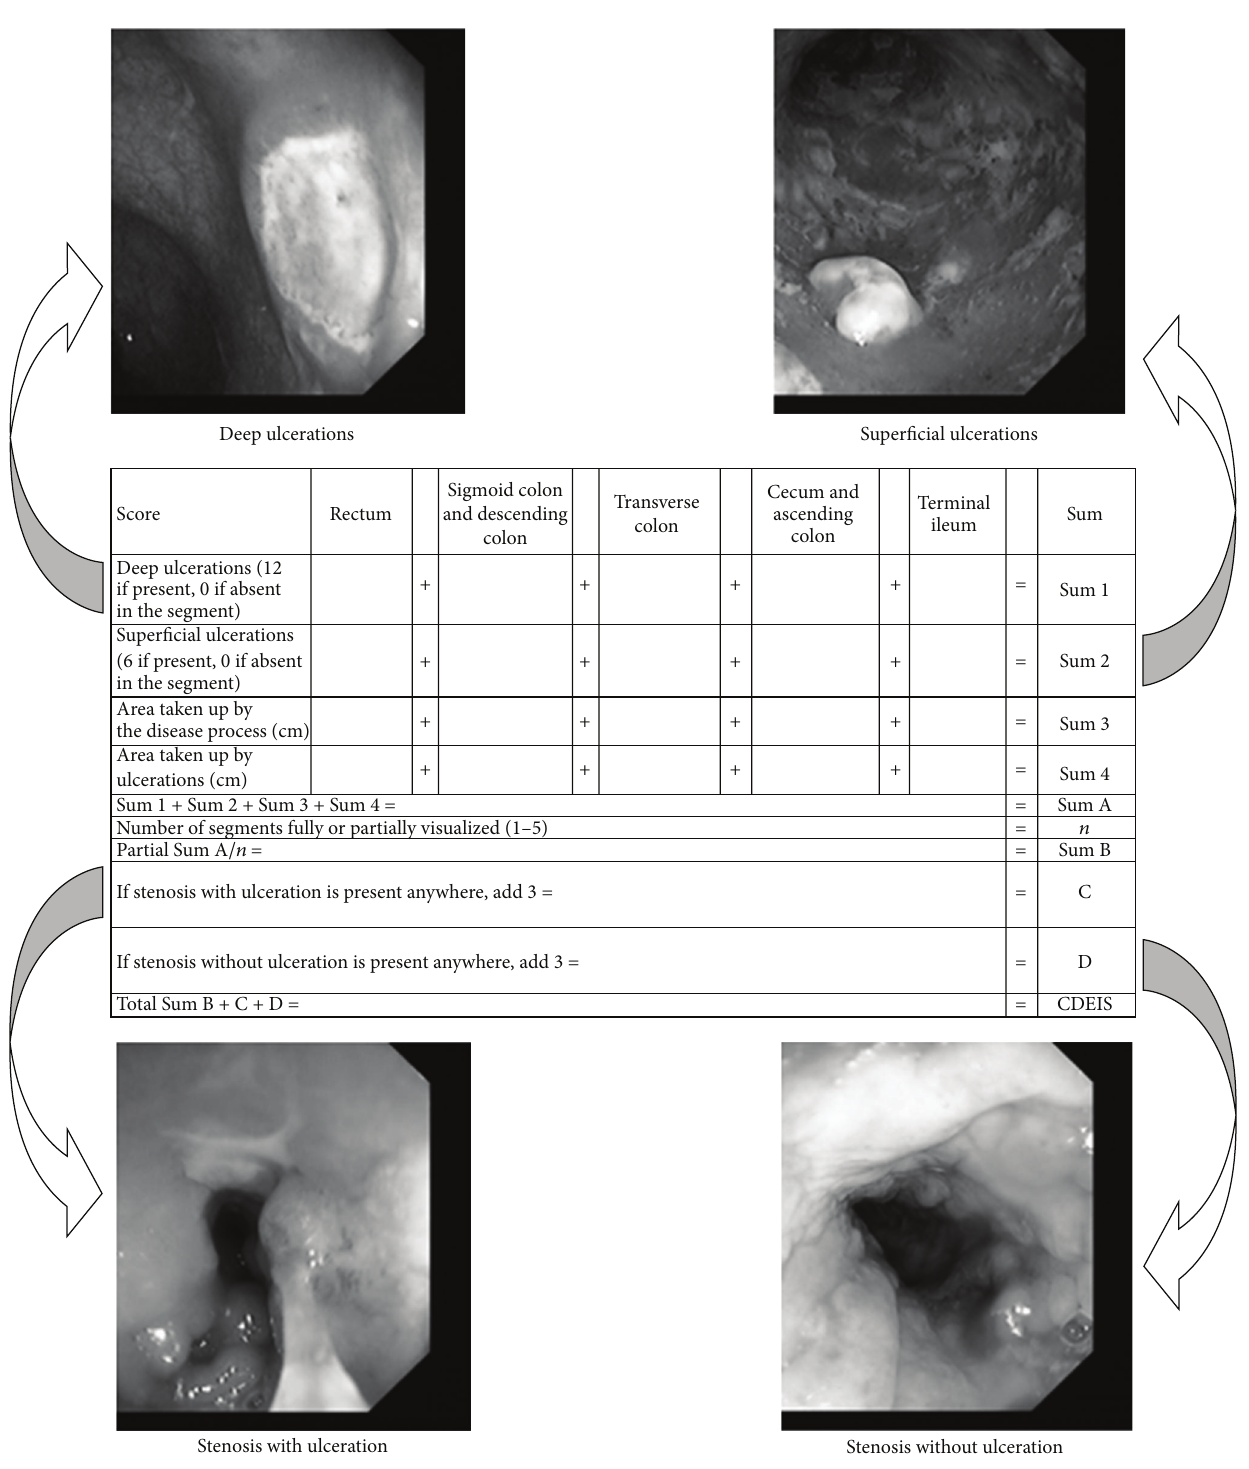
Figure 1: Example of how mucosal changes were evaluated on endoscopy. Crohn’s Disease Endoscopic Index of Severity (CDEIS).